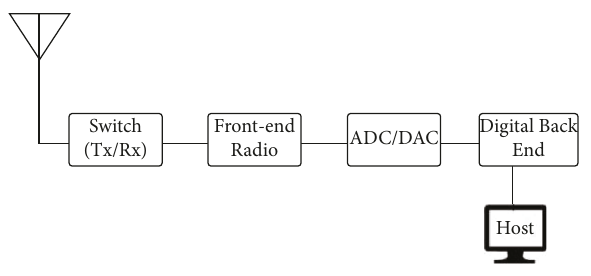
Figure 1: Basic block diagram of SDR.